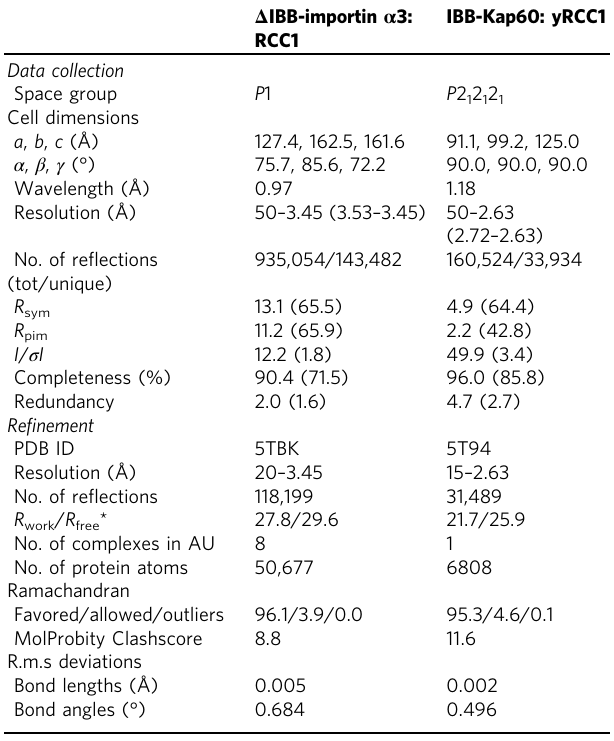
Table 1 Crystallographic data collection and re fi